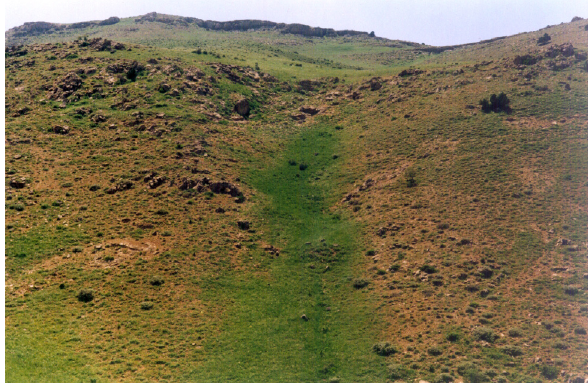
Fig. 12. Thymus-Bromus community